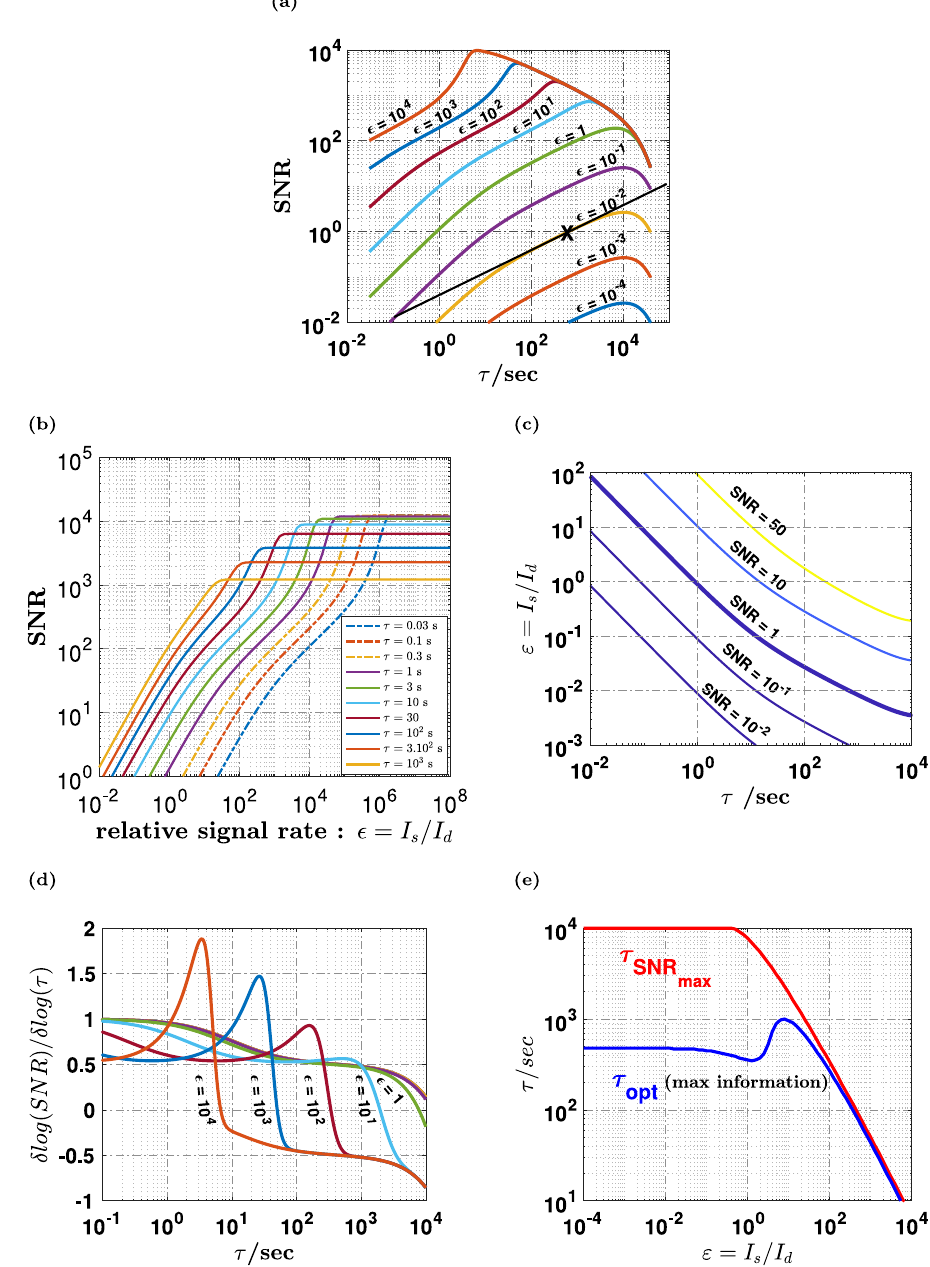
Figure 3. Simulation of the signal-to-noise ratio (SNR) for the whole detector. This figure shows the SNR for the whole detector as computed from the statistical model presented in the main text, using the individual pixel characteristics shown on Fig. 1a. ( a ) Shows the SNR as a function of the exposure time τ for different values of I s / I d of the signal count rate to the dark count rate. The black line with slope 1 / 2 , indicates the the ratio ε = √ τ regime discussed in the text, while the black cross indicates the value of the optimal time τ opt (600 s SNR ∝ 2 . ( b ) shows the same data as a function of ε for different values of τ . ( c ) Is a 10 here) described below for ε − = contour plot of the SNR. ( d ) Shows the logarithmic derivative of the SNR of plots shown in ( a ), while ( e ) shows the optimal exposure time τ opt (blue line) that gives the highest density of information and therefore the best detectivity. The time for maximum SNR (red line) is much